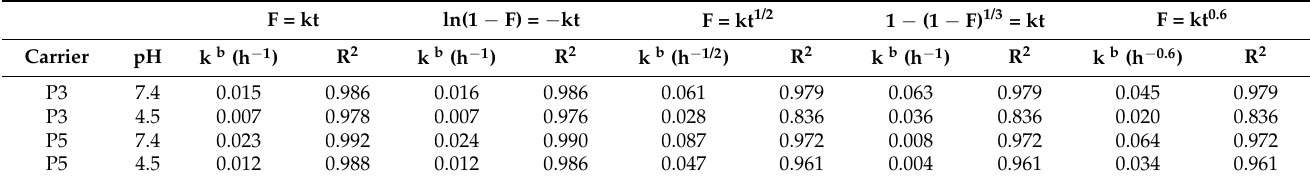
Table 4. Kinetic release constants of curcumin obtained using different mathematical models a .